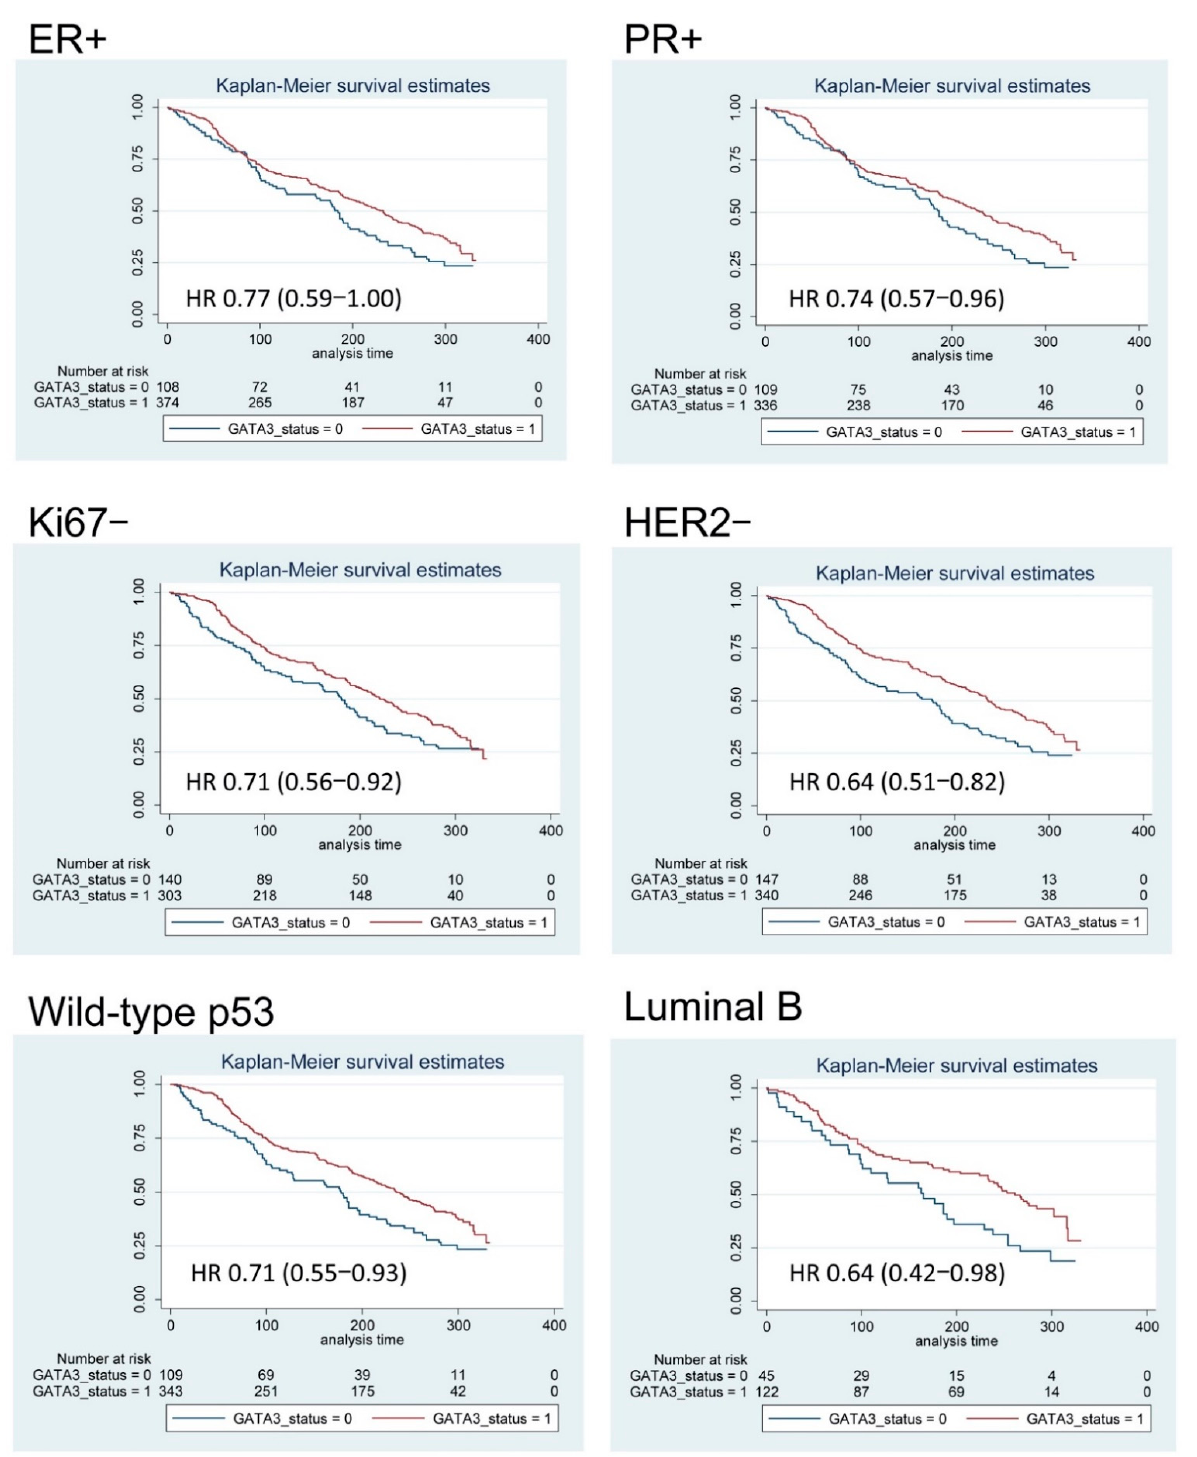
Figure 5. Kaplan–Meier overall survival curves of subgroups of breast cancer patients according to IHC expression of GATA3. After adjusting for the patients’ age, GATA3 IHC positivity was associated with a significantly better overall survival in breast carcinoma patients with positive (+) estrogen receptors (ER) and progesterone receptor (PR), negative ( − ) HER2 and Ki-67 (i.e., <20%), and p53 wild-type IHC pattern and Luminal B intrinsic subtype. The age-adjusted hazard ratio (HR) for death and the 95% confidence interval (CI) estimated with Cox regression analyses are reported.